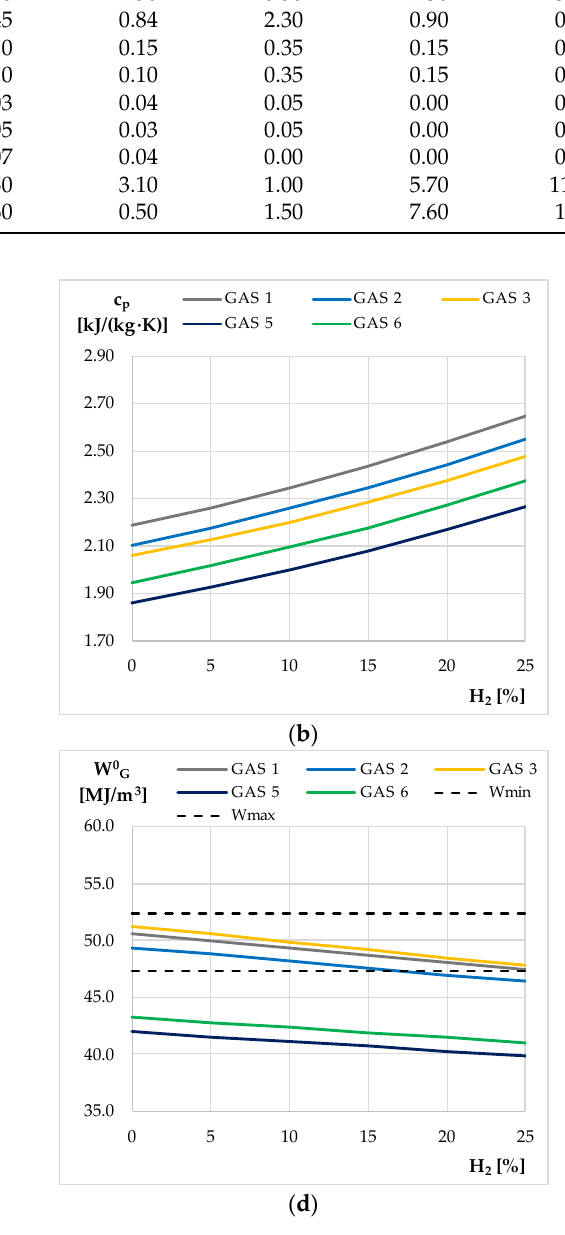
Figure 2. Trend of the thermophysical properties as a function of the H 2 content in NG mixtures: ( a ) relative density, ( b ) specific heat capacity, ( c ) higher calorific value, ( d ) Wobbe Index. Dashed lines represent the applicable limits